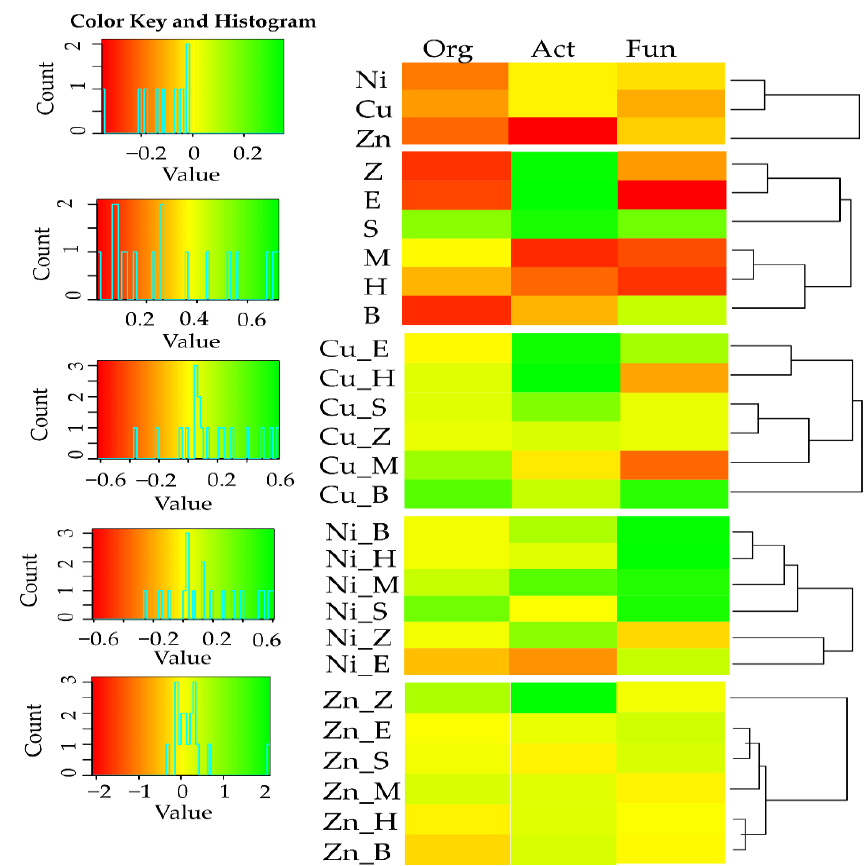
Figure 1. Index of the influence of heavy metals and sorbents on the number of